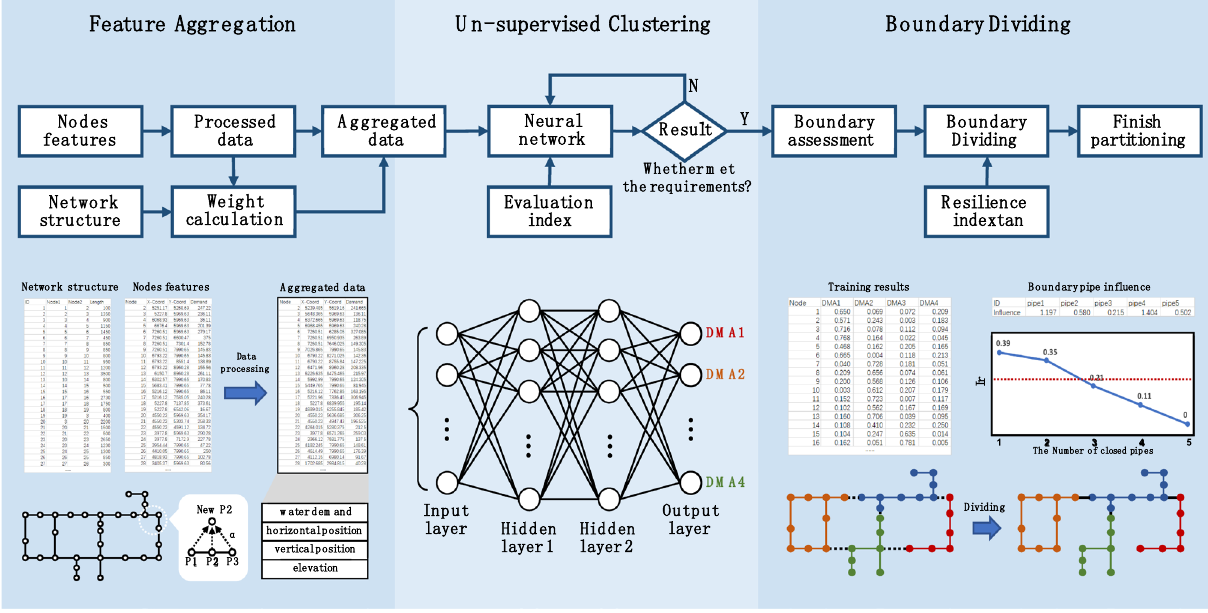
Fig. 1 Steps adopted for partitioning water